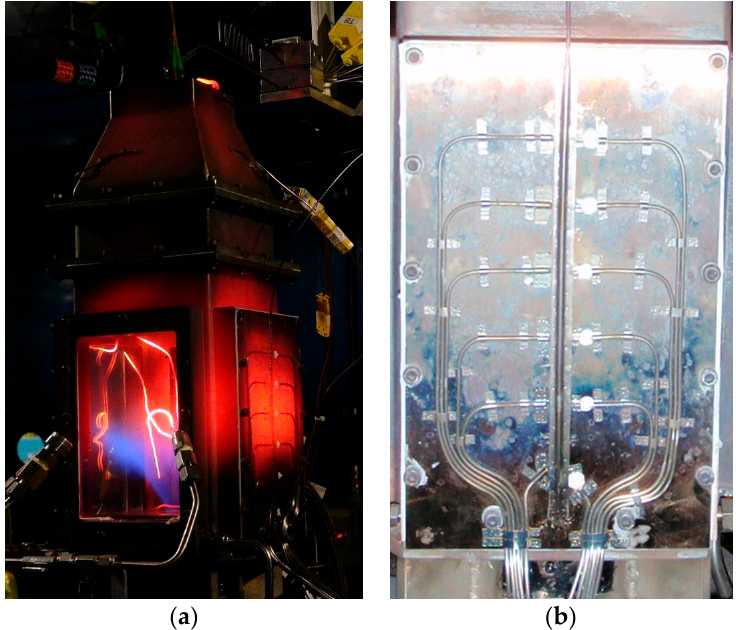
Figure 11. ( a ) Gas turbine combustor simulator operating with sidewall measurement panel, thermocouples and 1/16” tube packaged FBG sensor probe; ( b ) close up view of the sidewall panel at room temperature.